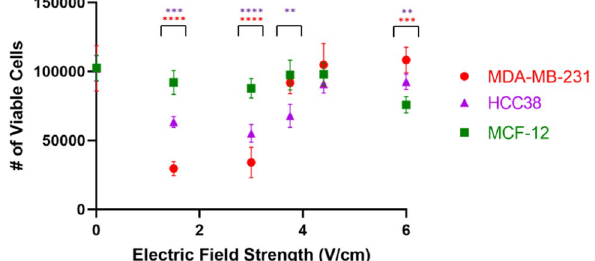
Fig. 7 Effects of TTField intensity on treatment efficacy and selectivity for TNBC and epithelial cells. TNBC cells (MDA-MB-231, HCC38) are significantly susceptible to lower TTField intensities than breast epithelial cells (MCF-12). All statistical significance compares TNBC cells to breast epithelial cells at the same electric field intensity ( P < 0.05 = *, P < 0.01 = **, P < 0.001 = ***, P < 0.0001 =